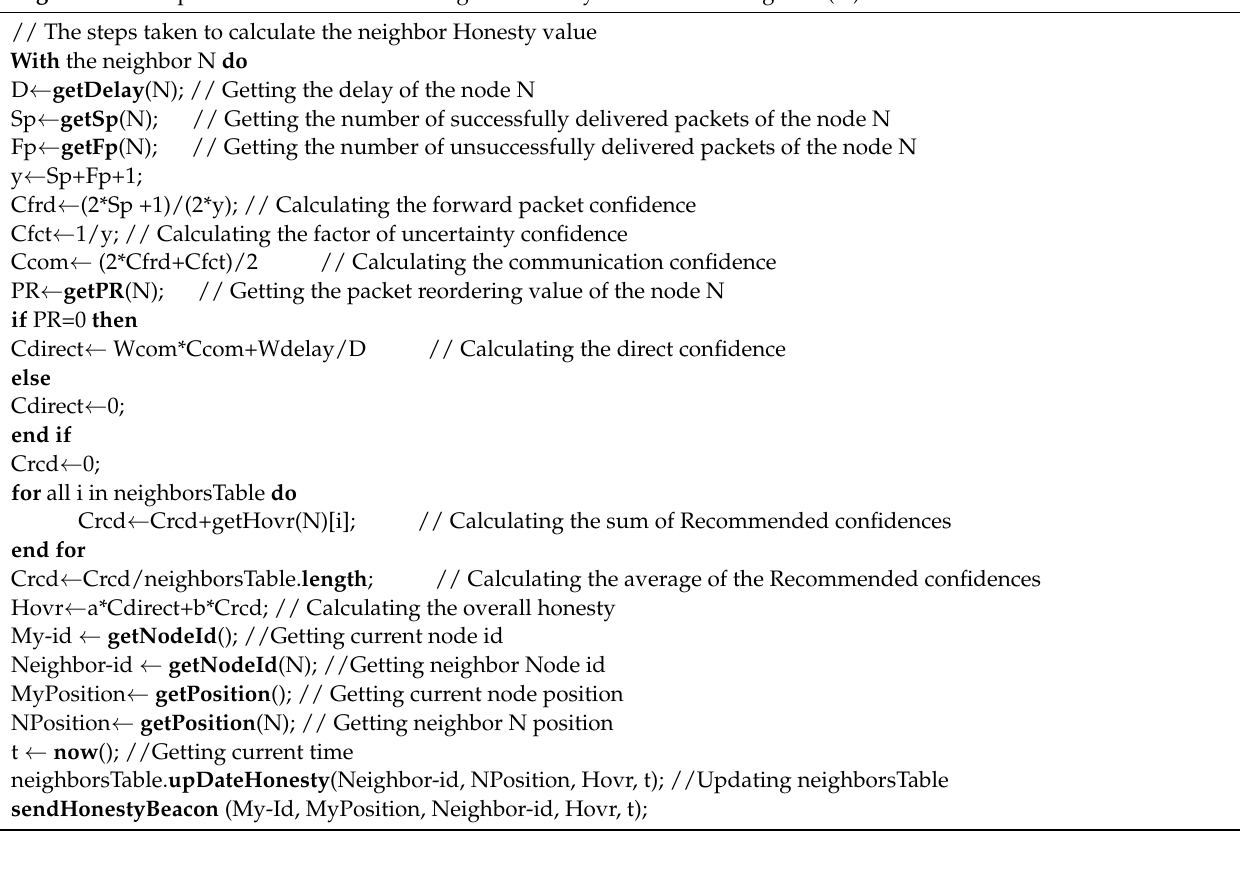
Algorithm 1. Steps involved when calculating the Honesty value for the neighbor (N). // The steps taken to calculate the neighbor Honesty